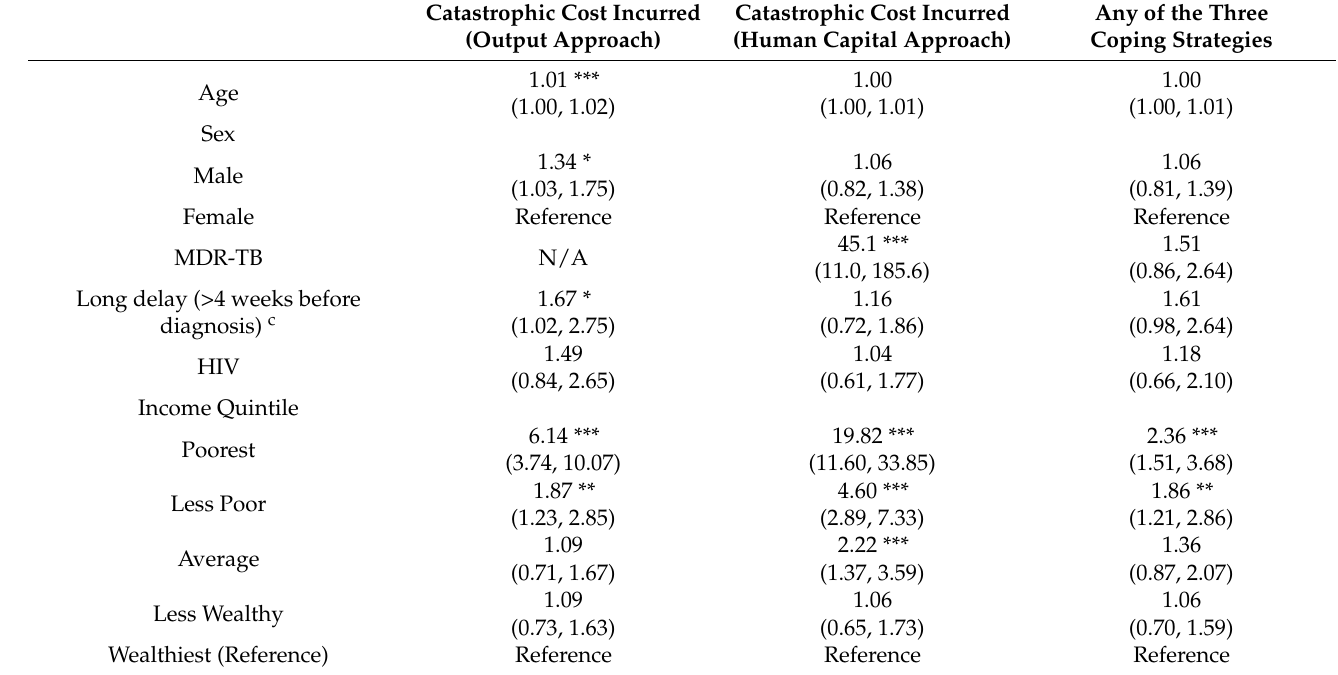
Table 5. Odds ratios of experiencing catastrophic costs under the two indirect cost methods and for engaging in any coping strategies a,b